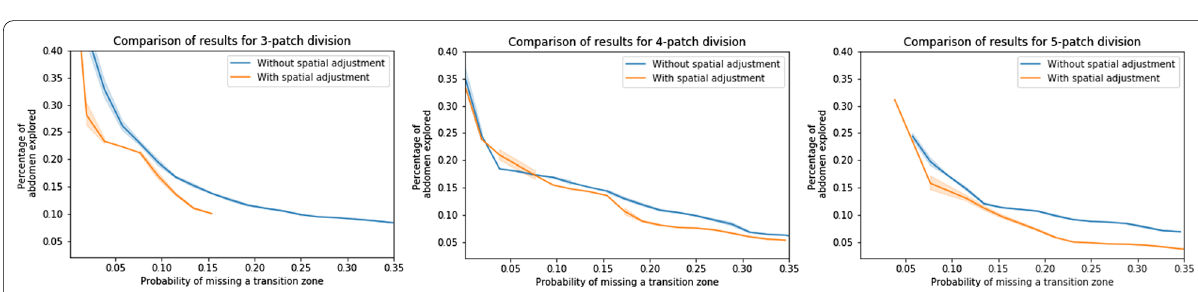
Fig. 6 Model abdominopelvic‑volume output according to the false‑negative ratio, with or without spatial